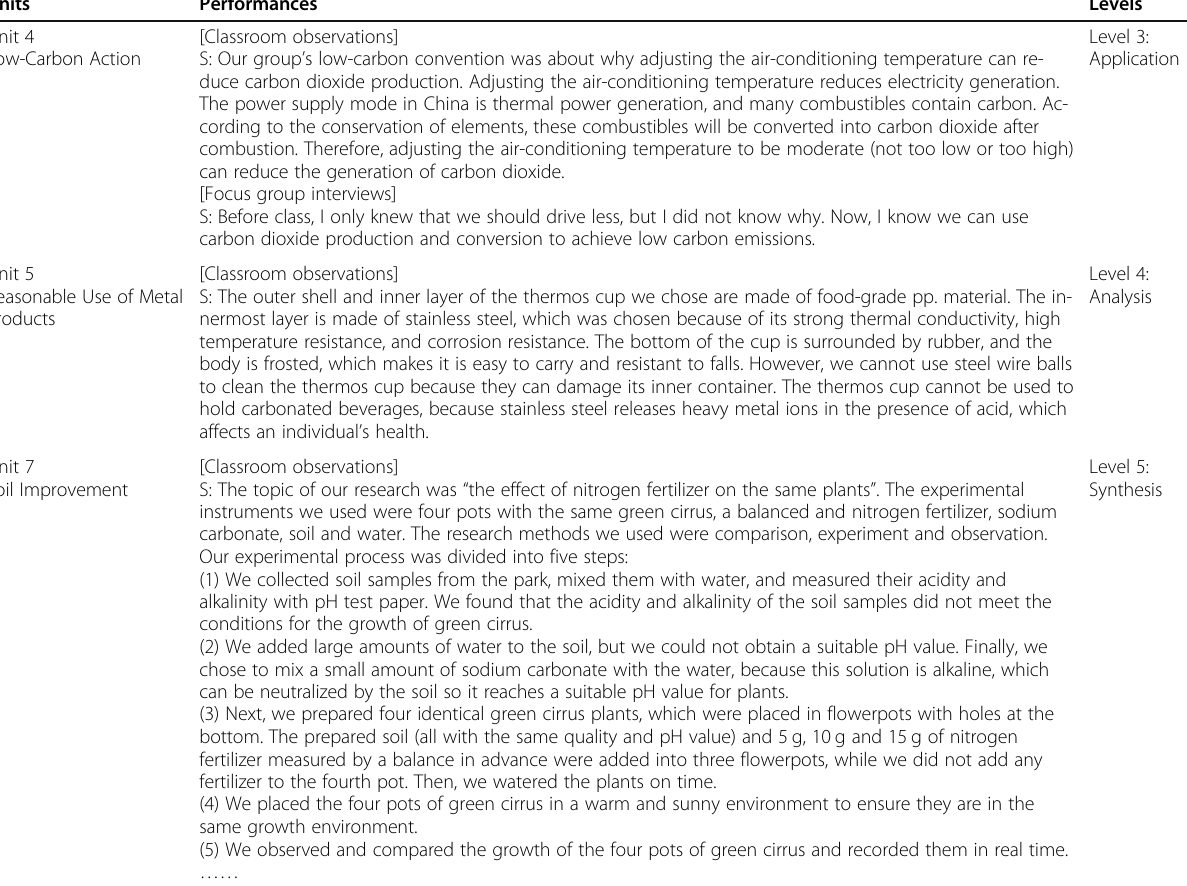
Table 6 Students ’ performances in understanding of “ the properties and transformation of substances ” Units Performances Levels Unit 4 Low-Carbon Action